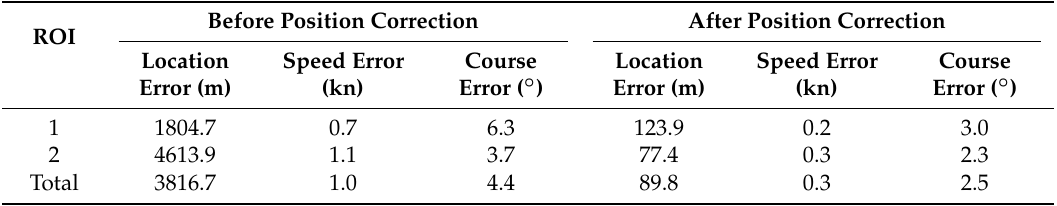
Table 3. Average error of motion